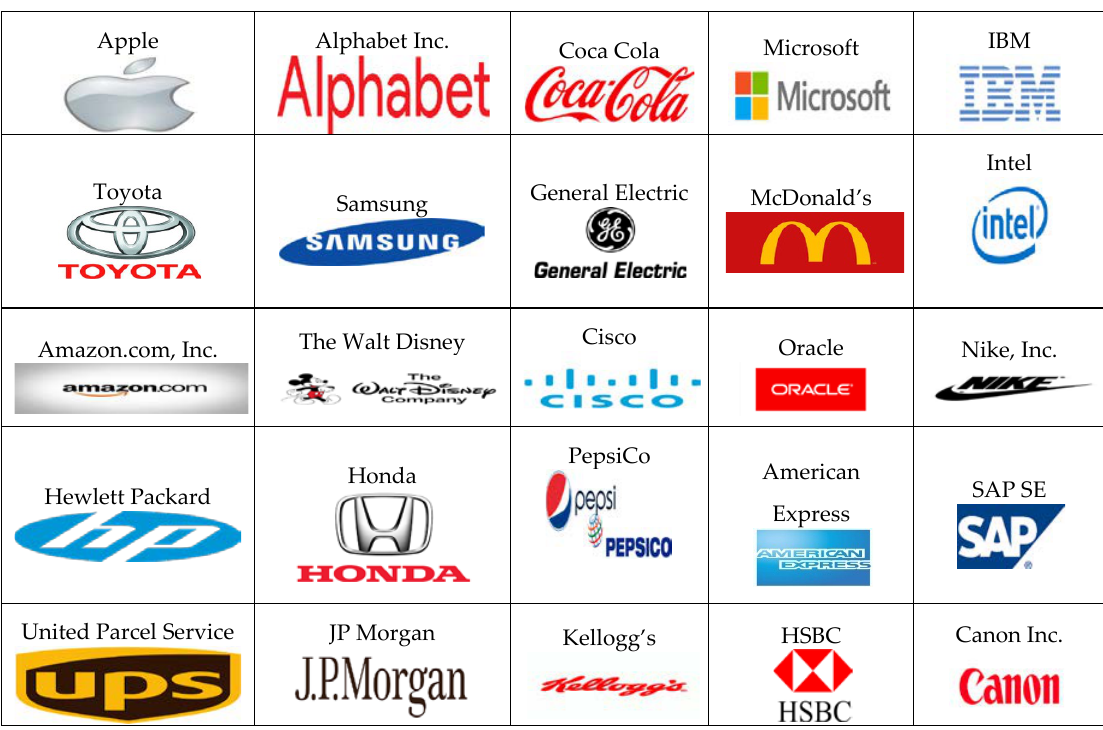
Figure A1. World top branded companies.